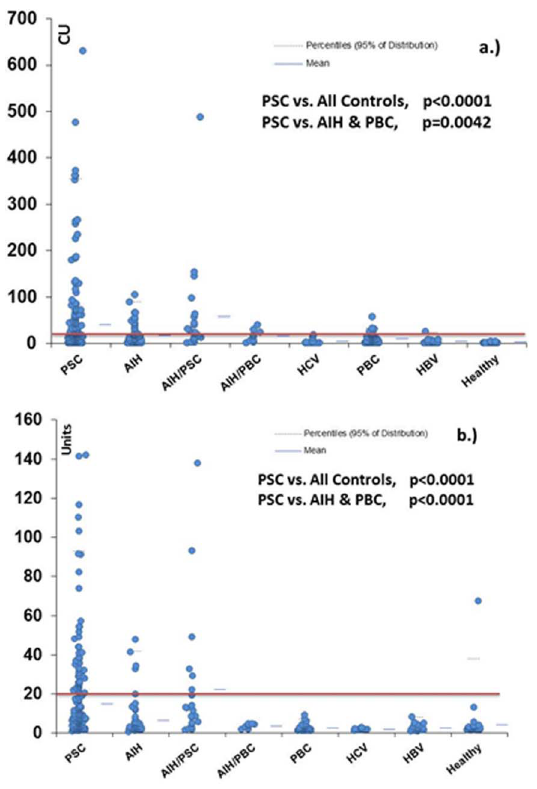
Figure 2. Comparative descriptive analysis. PR3-ANCA in primary sclerosing cholangitis (PSC) and various pathological and healthy controls (a. PR3-ANCA chemiluminescence immunoassay (CIA), b. PR3- ANCA ELISA). The recommended cut-off by the manufacturer is 20 chemiluminescent units (CU). Groups are as follows: autoimmune hepatitis (AIH); primary biliary cirrhosis (PBC); AIH-PSC overlap; AIH-PBC overlap; hepatitis C virus (HCV) infection; hepatitis B virus (HBV) infection; healthy